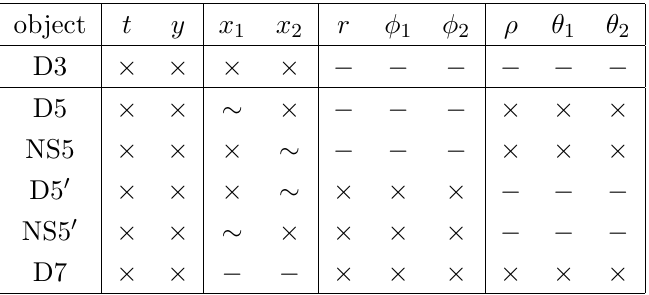
BPS brane system underlying the intersection of D5 – NS5 – D5 0 – NS5 0 – D7 Table 3 . The 1 8 branes intersecting D3 branes. The ∼ denotes smearing